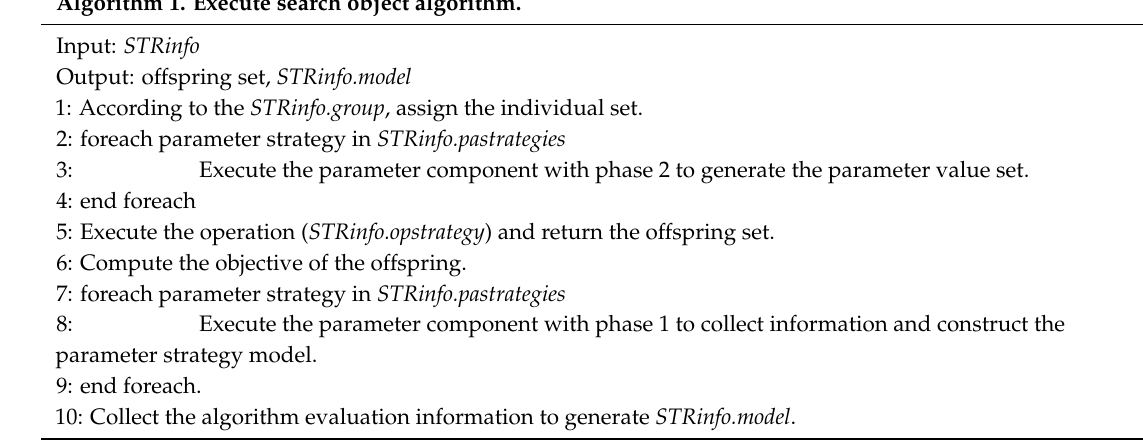
Algorithm 1. Execute search object